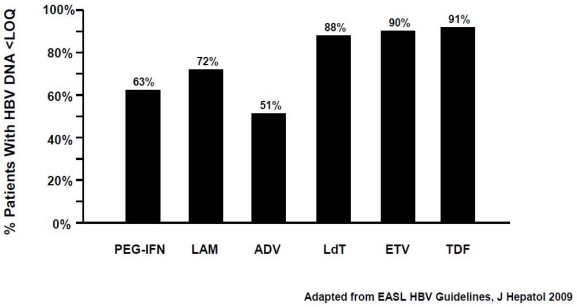
48-week rates of virological response (HBV DNA < 300/400 copies/ml) in NUC-naïve HBeAg-negative patients. Collation of currently available data – not from head-to-head studies.